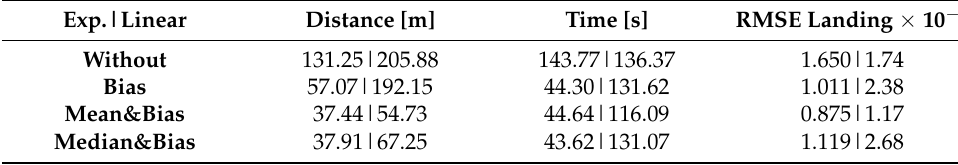
Table 6. Mean value of quality metrics.